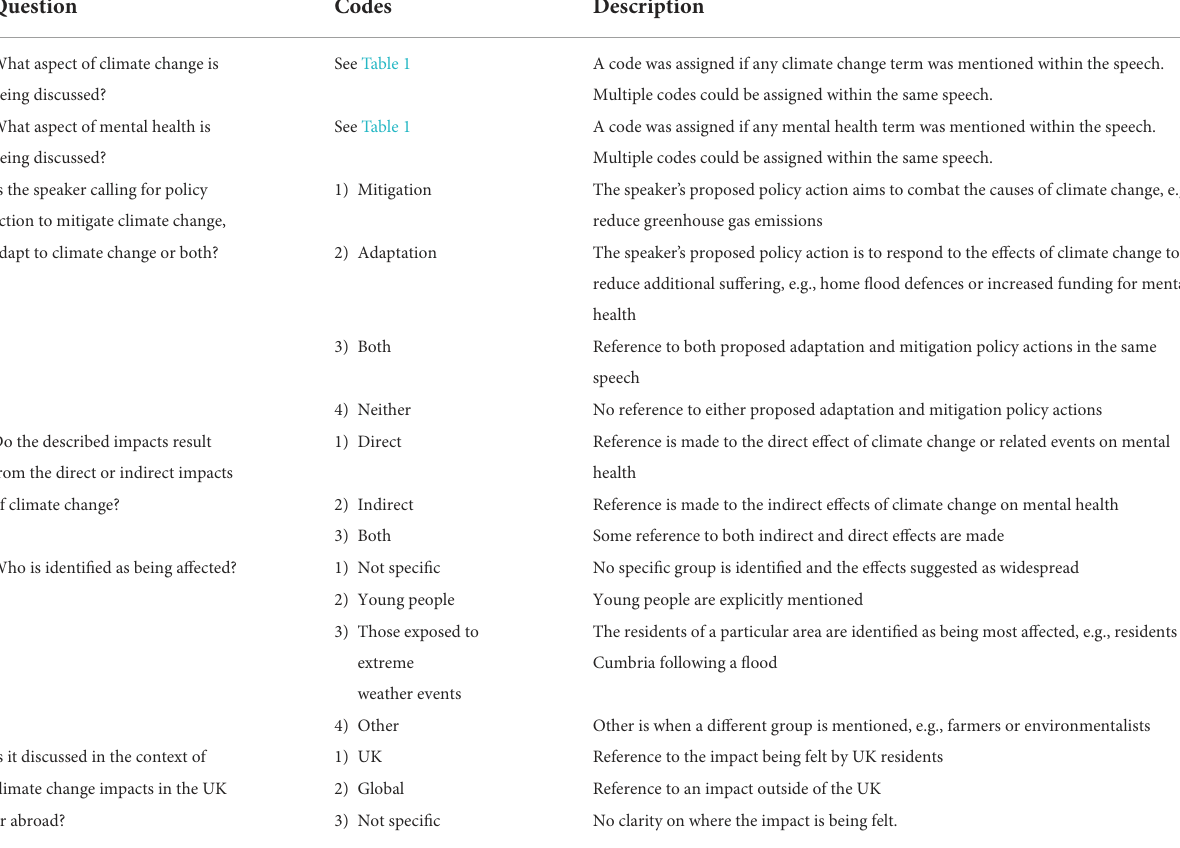
TABLE 2 Codes used for thematic analysis of relevant